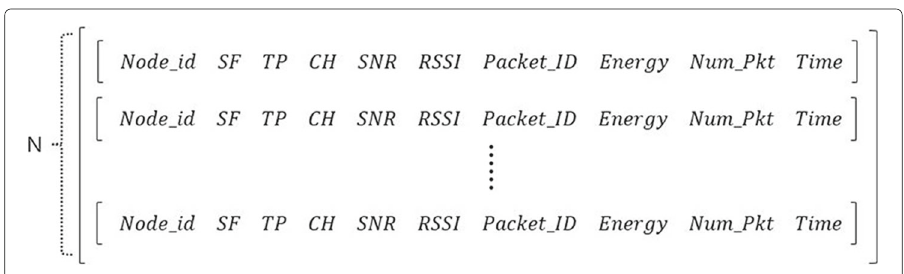
Fig. 4 State of the proposed